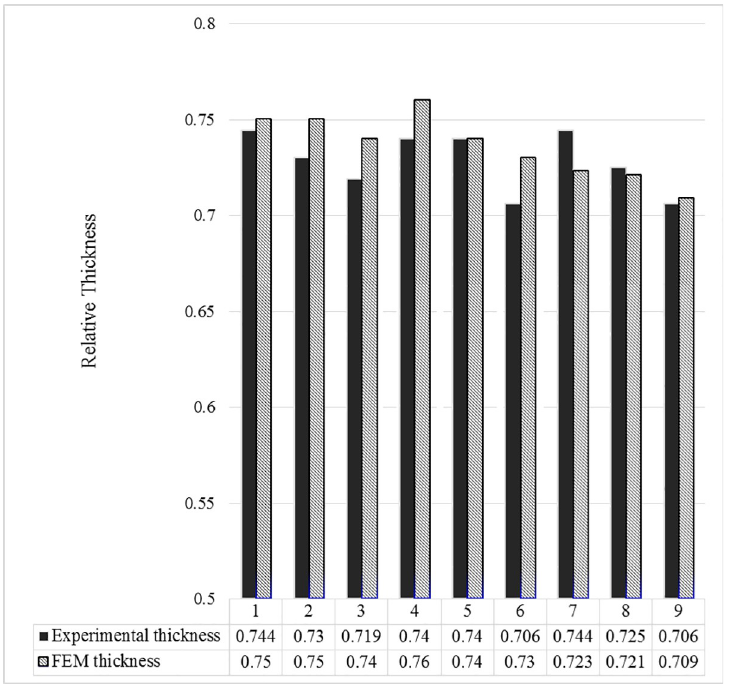
Fig 14. Experiments and finite element analysis (FEA) results.